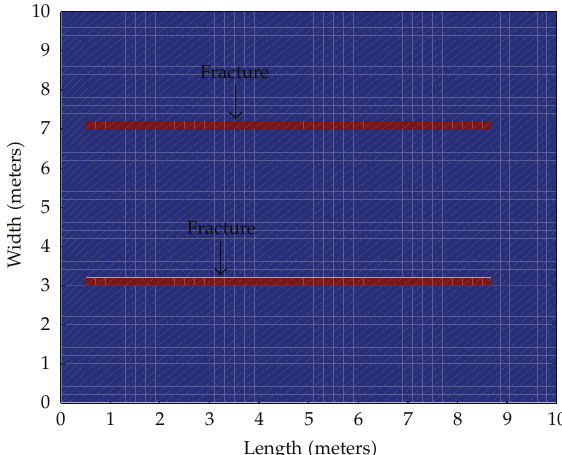
Figure 1: Distribution of fractures: Example 1.